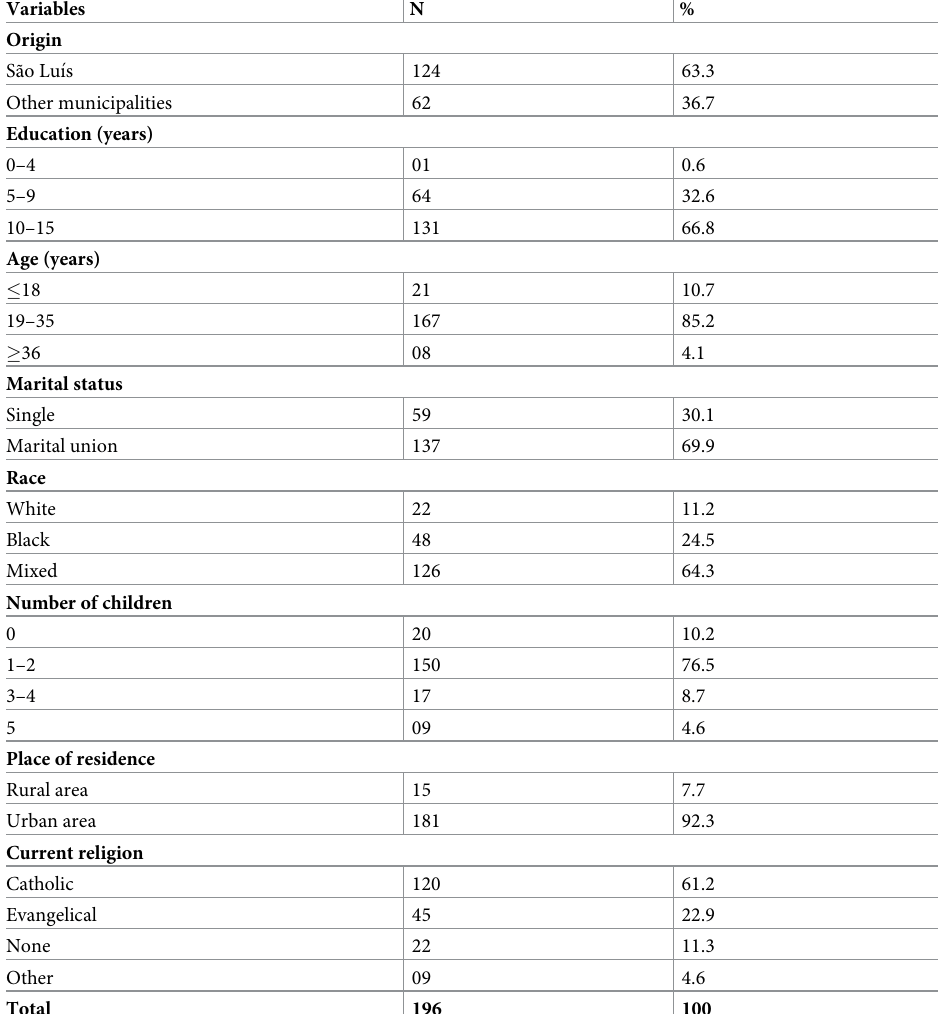
Table 2. Sociodemographic characteristics of the study